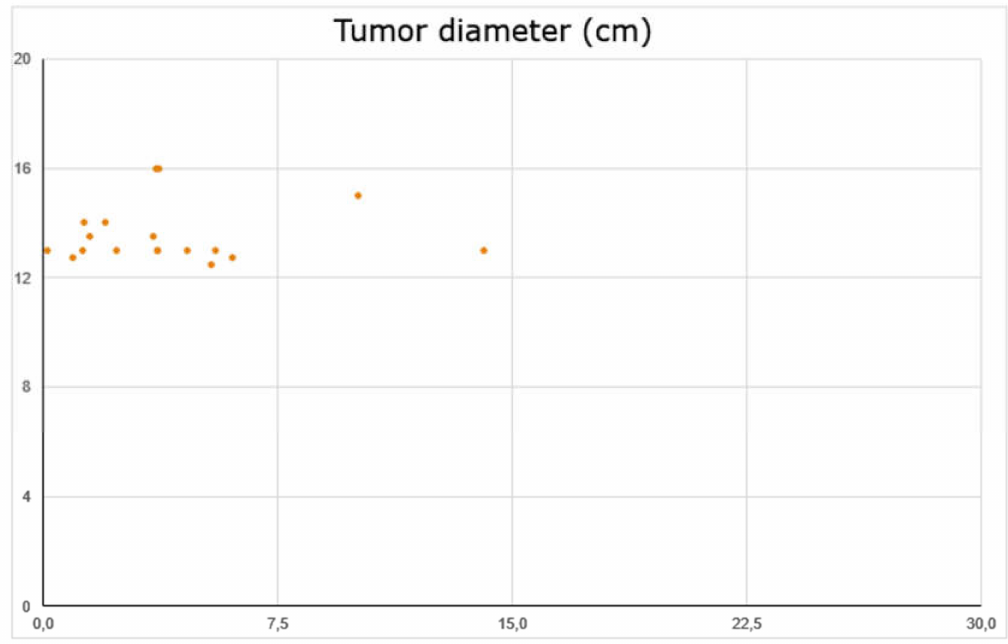
Figure 4. Tumor diameter versus minimal dose to the prescribed isodose